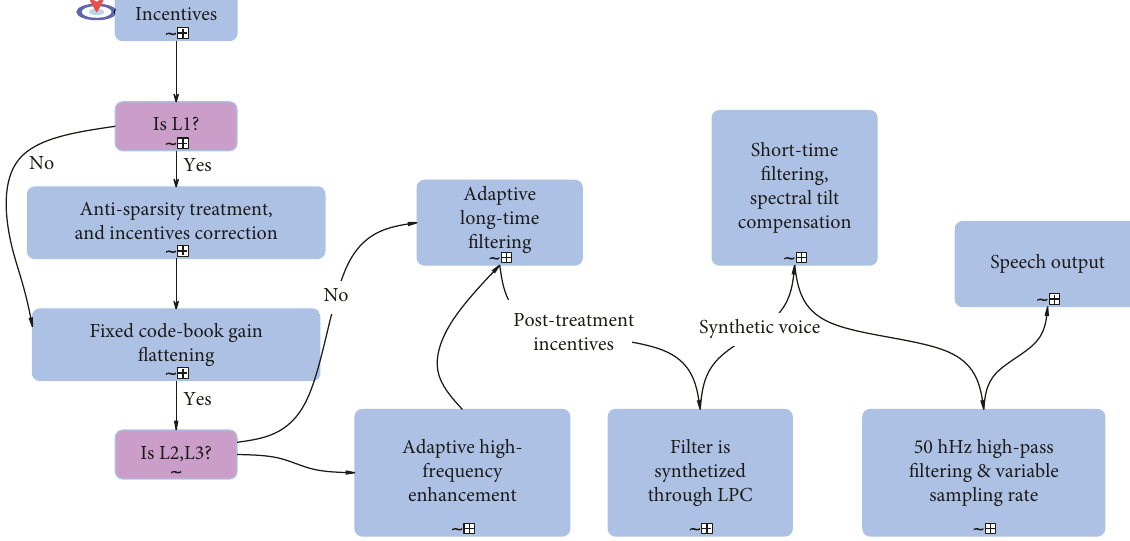
Figure 4: Postprocessing flowchart of this broadband embedded encoder.